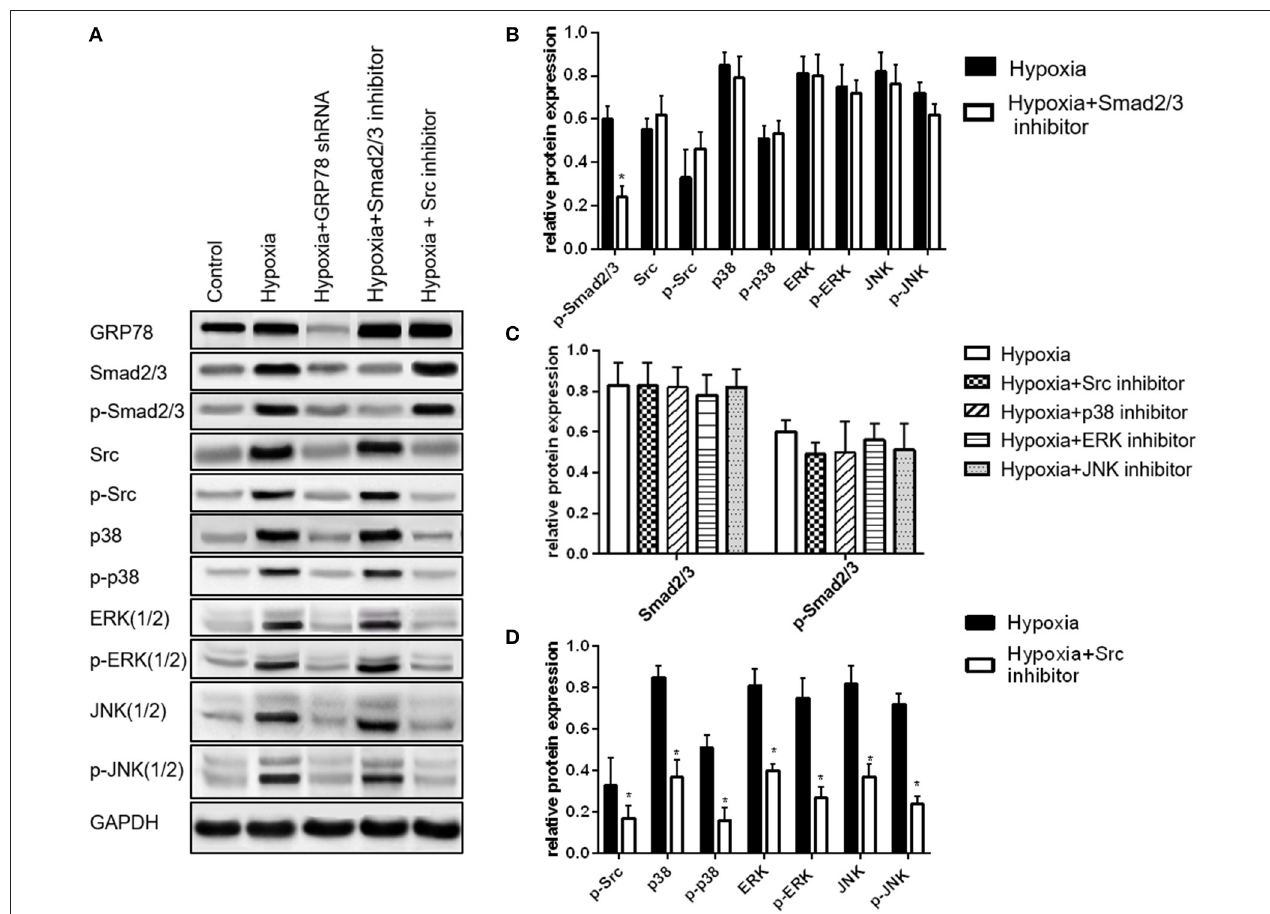
FIGURE 4 | Smad2/3 and Src/MAPK are two dependent signaling pathways in hypoxia-induced EMT in A549 cells. (A) Smad2/3, Src, p38, ERK, JNK, and their phosphorylated forms were examined by Western blot analysis. (B) Compared with the expression levels of Src, JNK, p38, ERK, and their activation forms in A549 cells under hypoxia, their expression levels do not change after inhibiting the activation of Smad2/3. (C) Compared with the expression levels of Smad2/3 and p-Smad2/3 in A549 cells under hypoxia, their expression does not change after inhibiting the activation of Src, JNK, ERK and p38. (D) * P < 0.05, compared with the expression levels of p38, ERK, JNK (three forms of MAPK) and their activated forms in A549 cells under hypoxia, their expression levels decrease after inhibiting the activation of Src. MAPK is the downstream pathway of